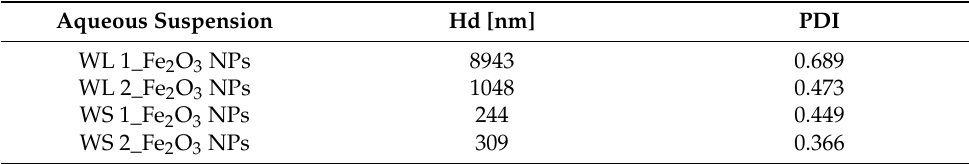
Table 2. Characteristics of the aqueous